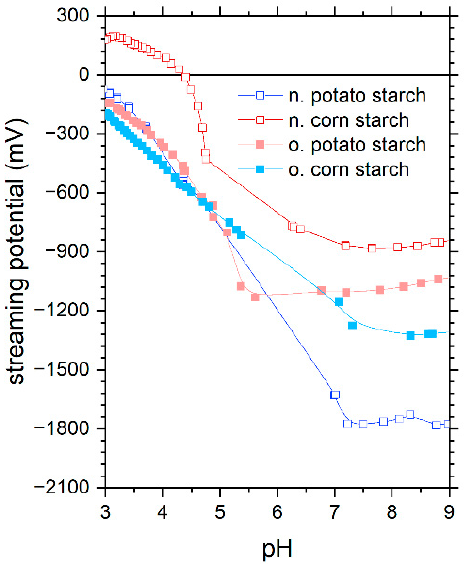
Figure 1. The streaming potential of starches as a function of pH in the pH range of 3 to 9 on native potato starch (blue), native corn starch (red), oxidized potato starch (light blue), and oxidized corn starch (pink). These data were reported recently by our author team [16].